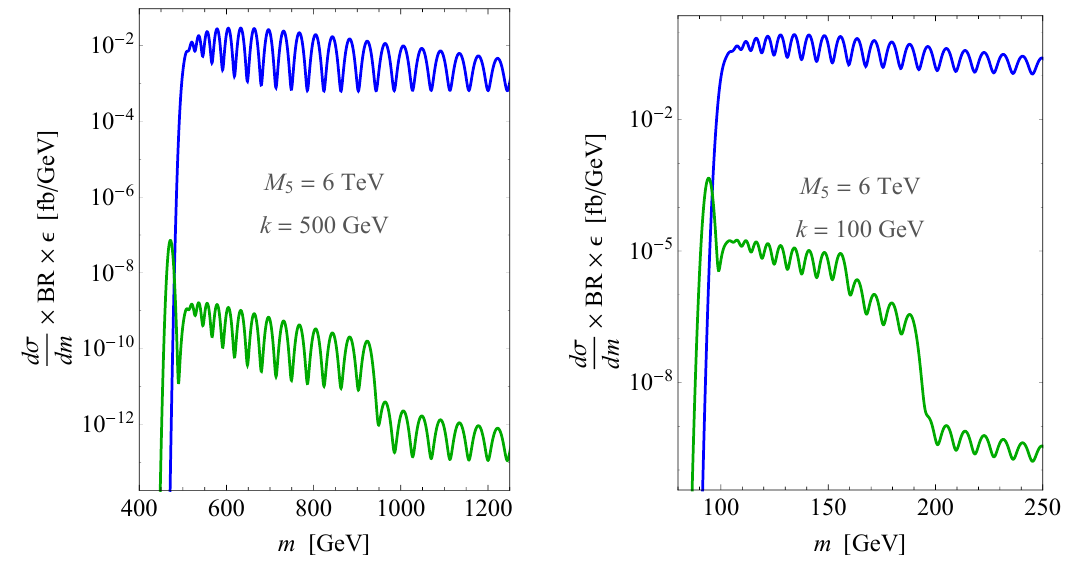
Figure 13 . The diphoton signal of the scalar KK modes (the lower curve, green) vs. that of the KK gravitons (the upper curve, blue) for k = 500 GeV (left) and 100 GeV (right), in the case of rigid boundary conditions for the dilaton